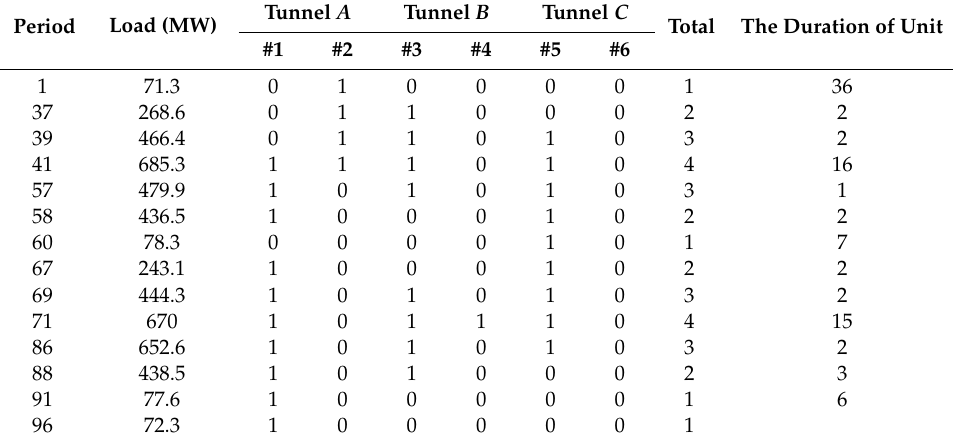
Table 6. Unit state in dry season with low-rate